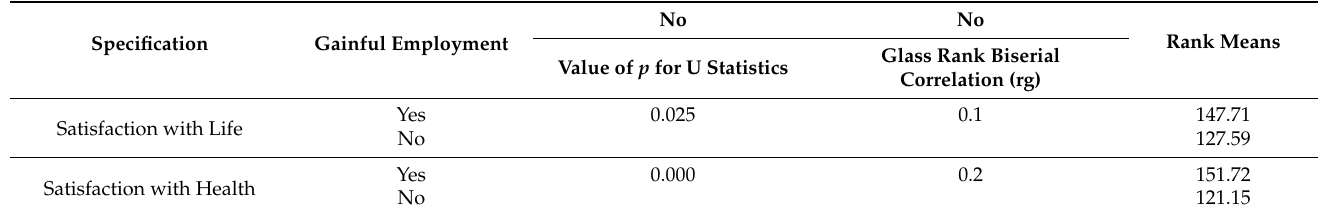
Table 8. Satisfaction with life, health, and particular domains of quality of life (WHOQOL-BREF) of female students by gainful employment/professional activity (H test, E 2 R , U test,